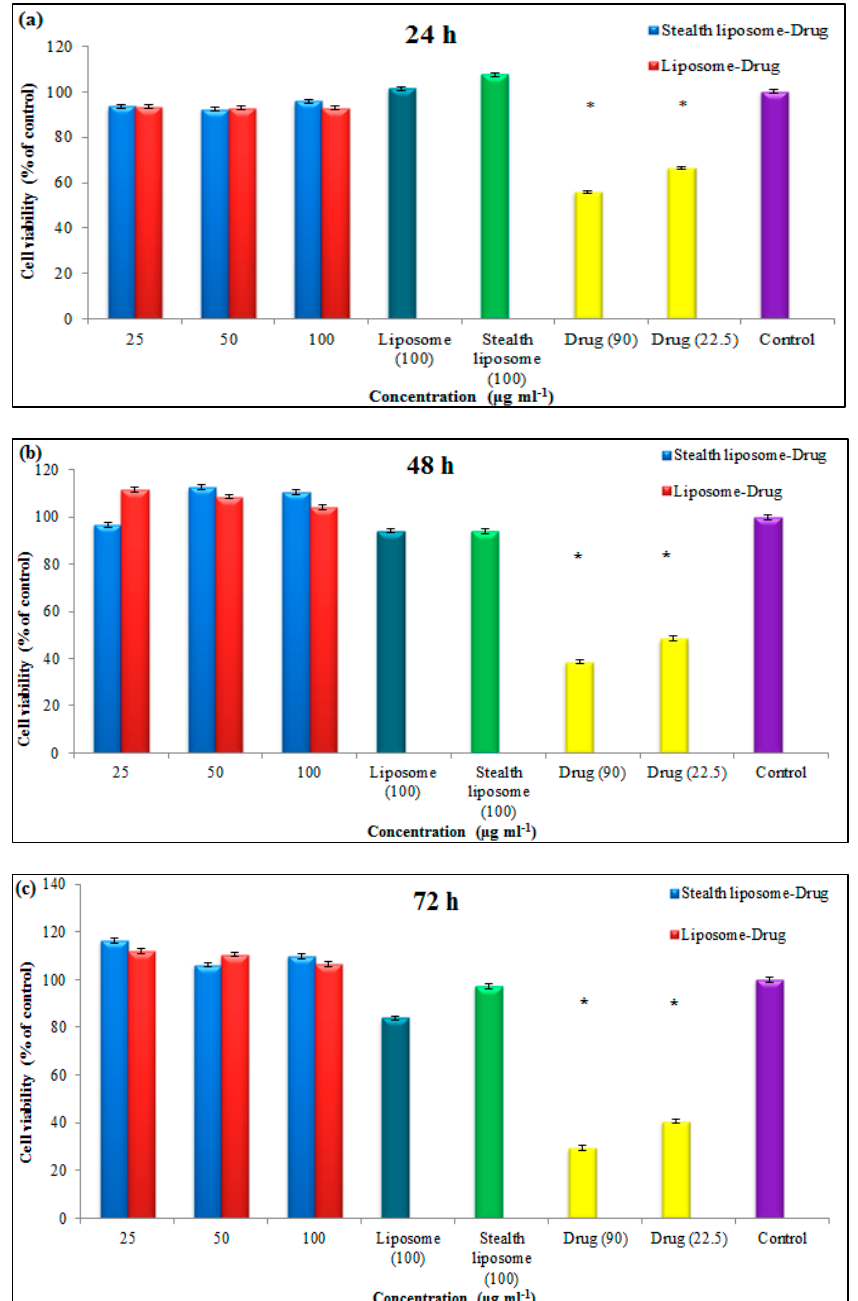
Figure 7. Results of MTT assay of liposome and stealth liposome after ( a ) 24 h, ( b ) 48 h, and ( c ) 7 h on the L929 cell line (* p ≤ 0.05).